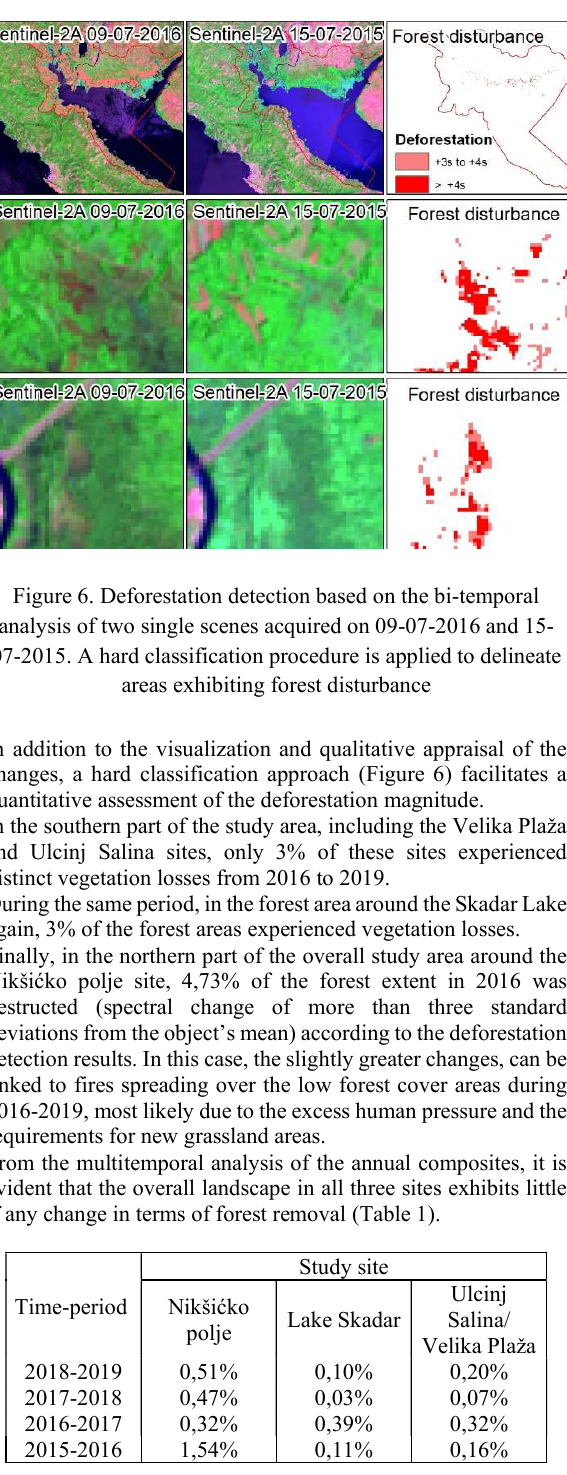
Table 1. Deforestation detection within each of the test sites (percent of total area)